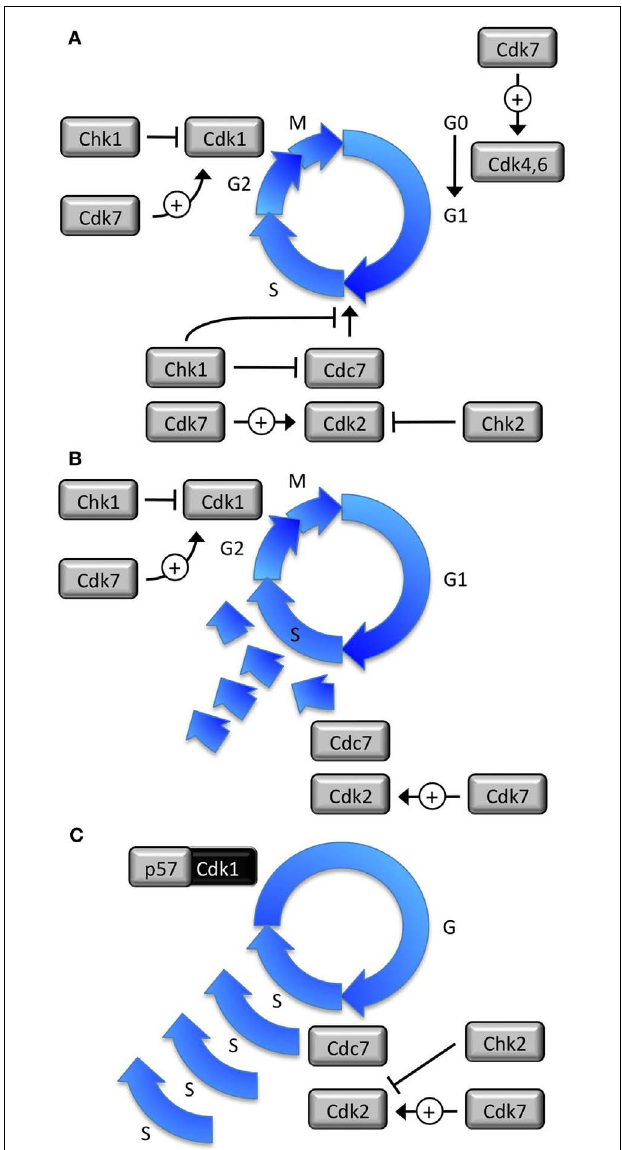
FIGURE 1 | Eight protein kinases regulate DNA replication in mammalian cells. (A) Mitotic cell cycles produce one and only one copy of the nuclear genome per cell division. Cdk7 • CcnH activates Cdk1, Cdk2, Cdk4, and Cdk6. Cdk4 • CcnD and Cdk6 • CcnD drives cells from a quiescent state (G0) into a proliferative state. Cdk1 • CcnB1 triggers mitosis. Cdc7 • Dbf4 and Cdk2 • CcnE initiate DNA replication. Cdk2 • CcnA2 prevents DNA re-replication. Cdk1 • CcnA2 prevents premature initiation during G2 phase. Chk1 inhibits Cdk1 and Cdk2 in response to either stalled replication forks or DNA damage. Chk2 inhibits Cdc7 and Cdk2 in response to double strand DNA breaks. (B) If proliferating cells attempt to re-replicate their nuclear DNA before exiting the mitotic cell cycle, the result is a random accumulation of partially re-replicated chromosomes that generates cells with > 4C but < 8C DNA content that undergo apoptosis. (C) Endocycles produce multiple copies of the nuclear genome in the absence of cell division. In trophoblast giant cells, Cdk2 is essential for DNA replication in the absence of Cdk1 activity, which is inhibited by p57, and Chk1 is selectively suppressed. Cdc7 and Cdk7 are essential for initiation of preIC assembly. Cdk4 and Cdk6 are assumed to be